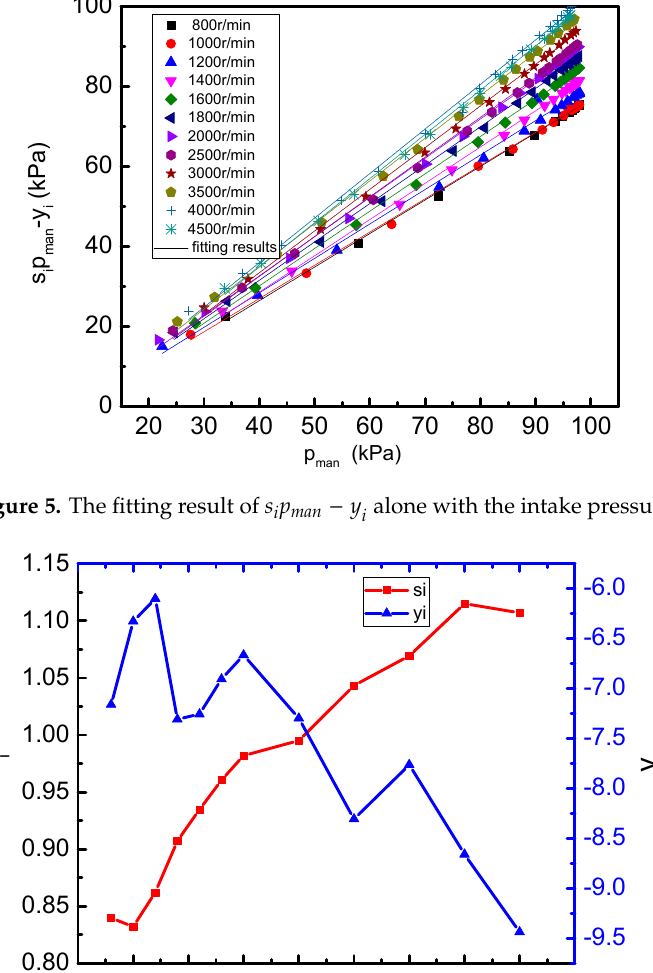
Figure 6. The calculated s i and y i alone with the engine speed.